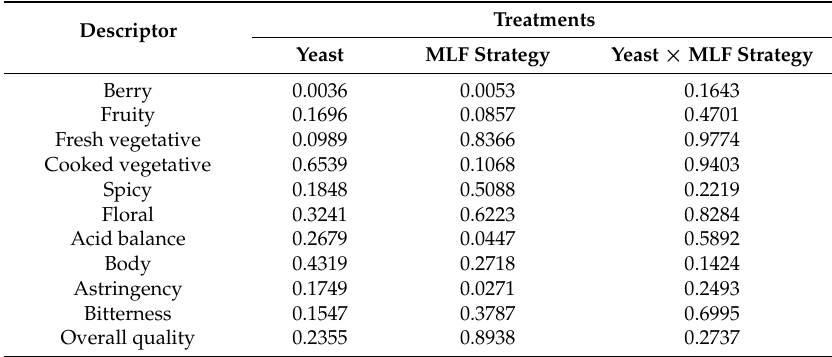
Table 5. Probability ( p ) values 1 of Shiraz wines produced with the different yeast treatments and malolactic fermentation (MLF)